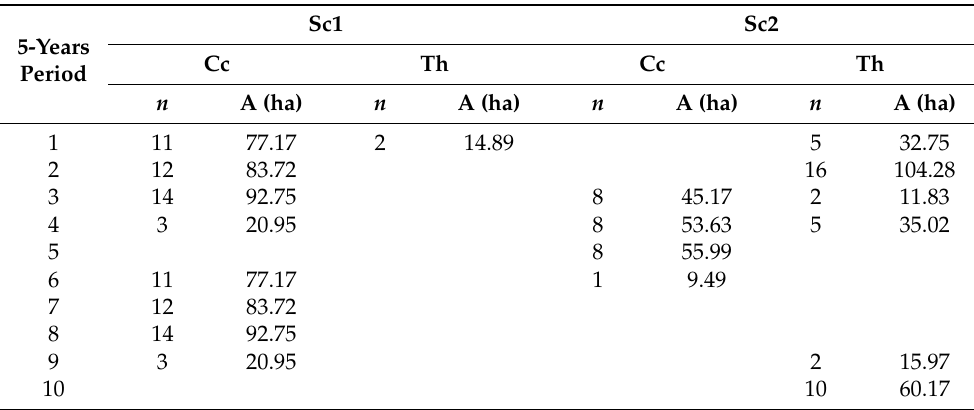
Table 5. Characterization of FMO_all results according to the optimal solution during the planning horizon, discriminated by